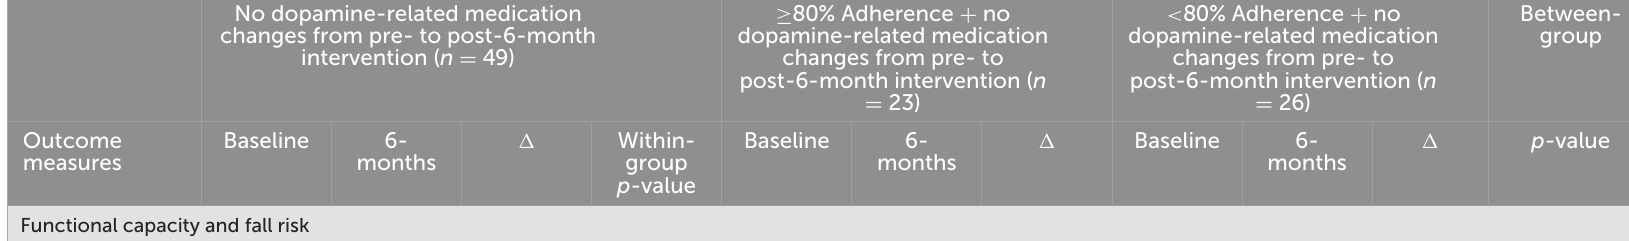
TABLE 3 Summary of results excluding those with a change in dopamine-related medication from pre- to post-6-month